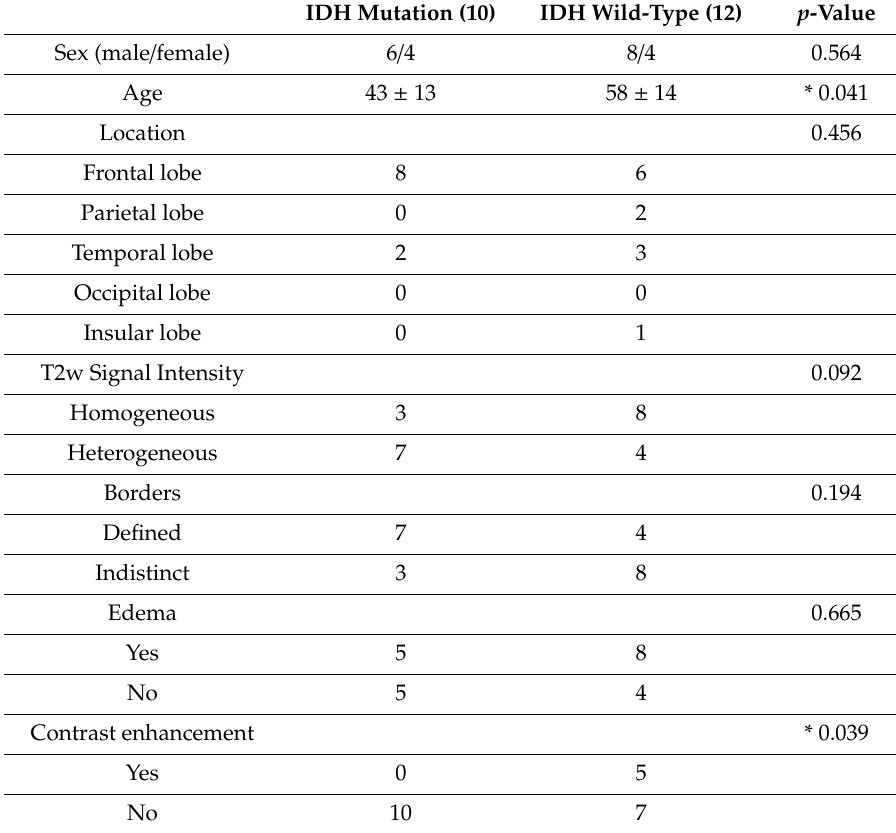
Table 1. The main clinical and conventional MRI (cMRI) features of the isocitrate dehydrogenase (IDH) mutational status in grade III astrocytomas.